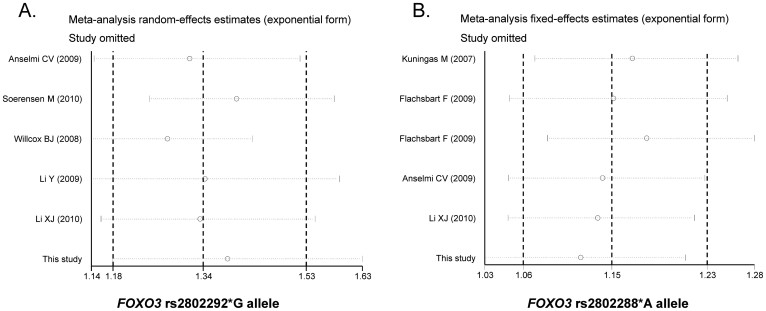
Sensitivity analyses by deleting each study to reflect the influence of the individual dataset to the pooled ORs in allele-contrast model.(A) rs2802292*G; (B) rs2802288*A.